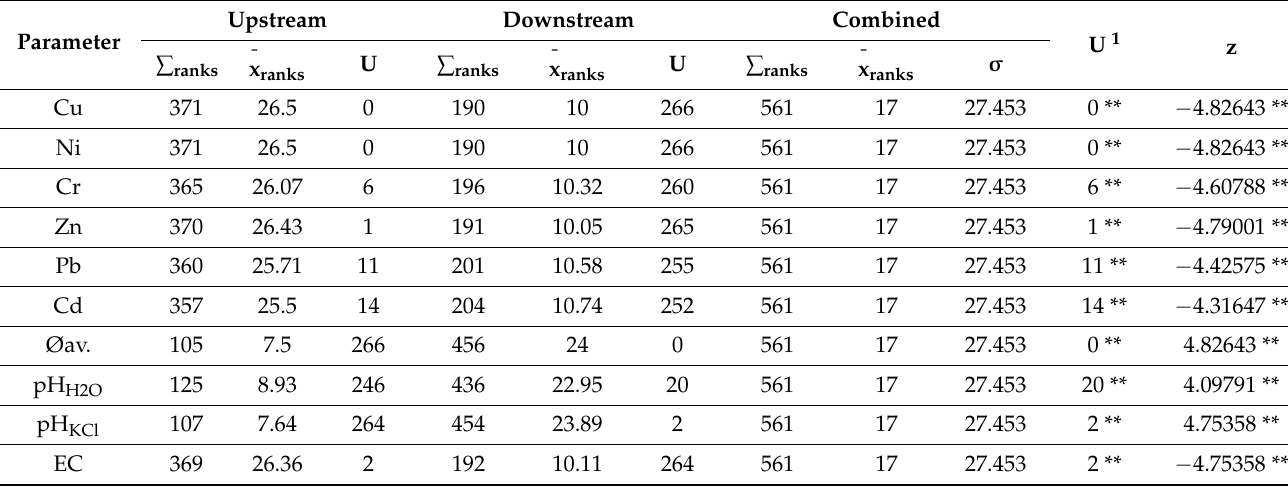
Table 8. The results of the analysis of the Mann–Whitney test for the tested parameters of the bottom sediment near the hydropower plant on the ´Sl˛eza River. Parameter